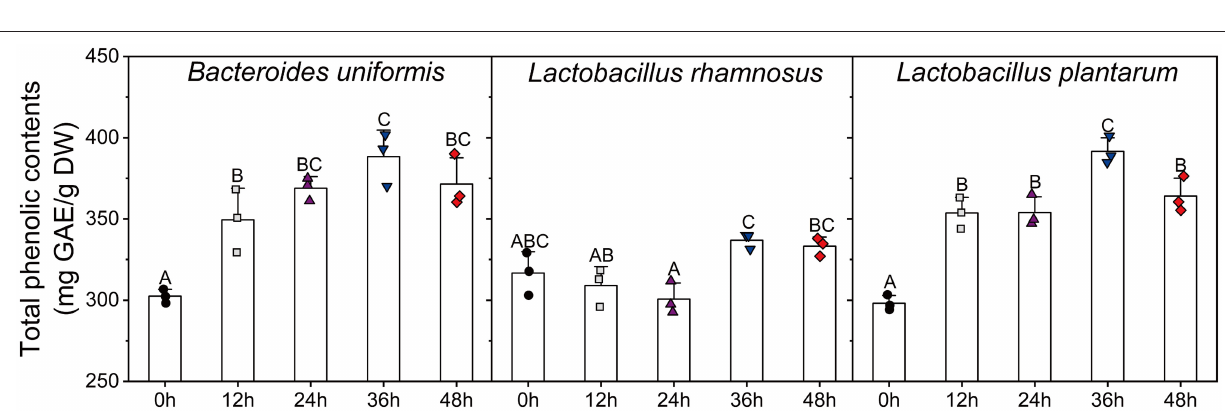
FIGURE 4 | Structure of quercetin-3- O -rutinose-7- O - α -L-rhamnoside (A) and negative MS spectra (B,C) of two new-synthesized substances in L. plantarum culture by fission of C-ring of quercetin-3- O -rutinose-7- O - α -L-rhamnoside.